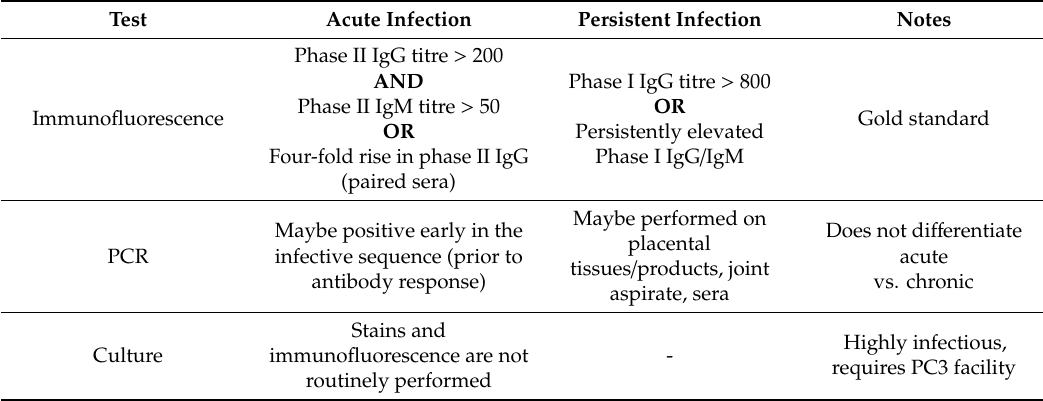
Table A2. Diagnostic methods for acute and persistent Q fever